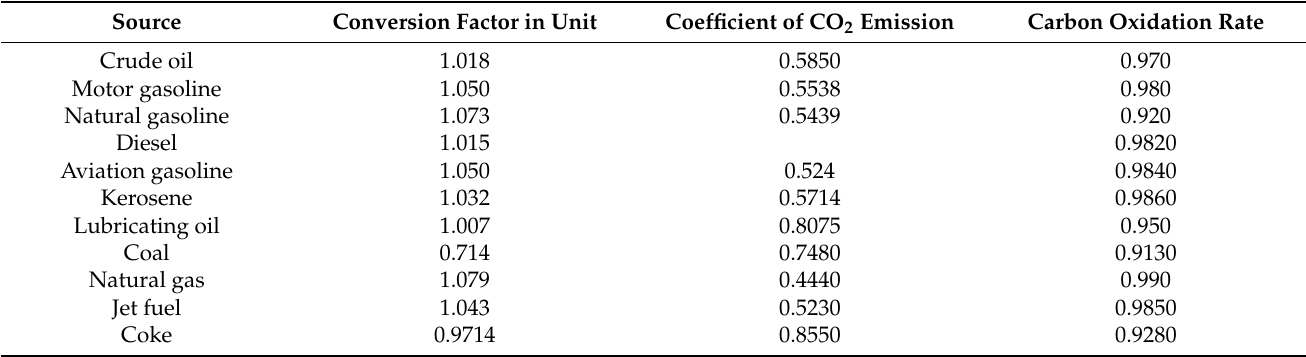
Table 1. Tons of oil equivalents in conversion factors from their physical